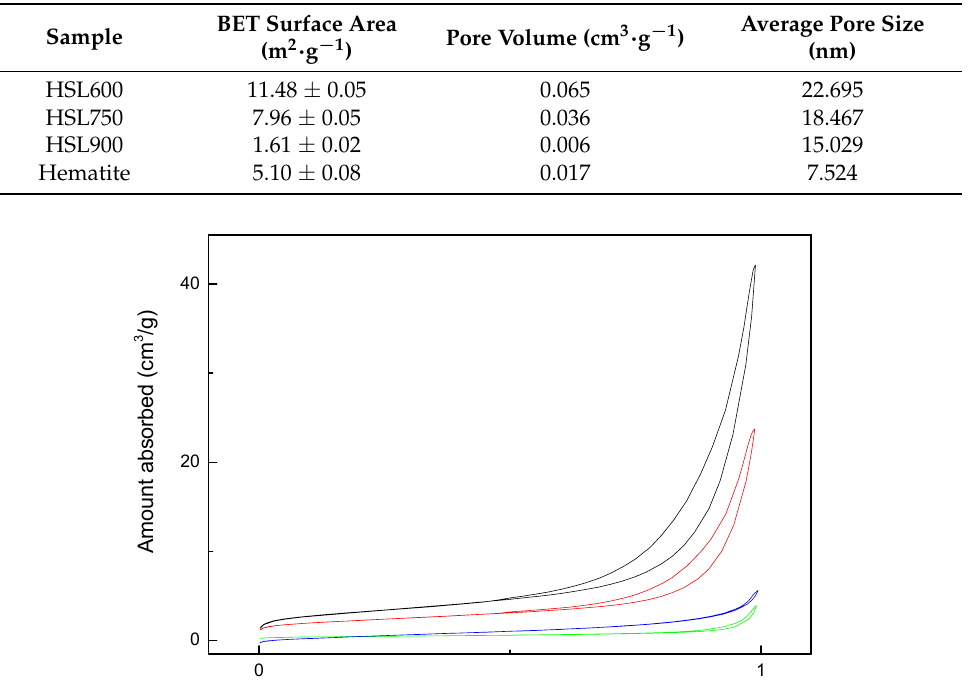
Figure 3. Nitrogen adsorption-desorption isotherms of HSL600 (black), HSL750 (red), HSL900 (green) and hematite (blue) samples.